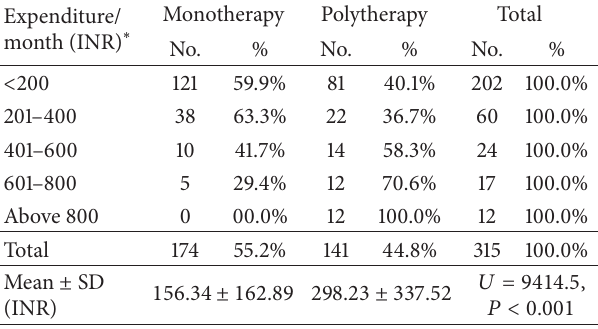
Table 4: Distribution of the study population according to the average expenditure for food and lodging for their visit to Medical College Hospital ( 𝑛 = 315 ).